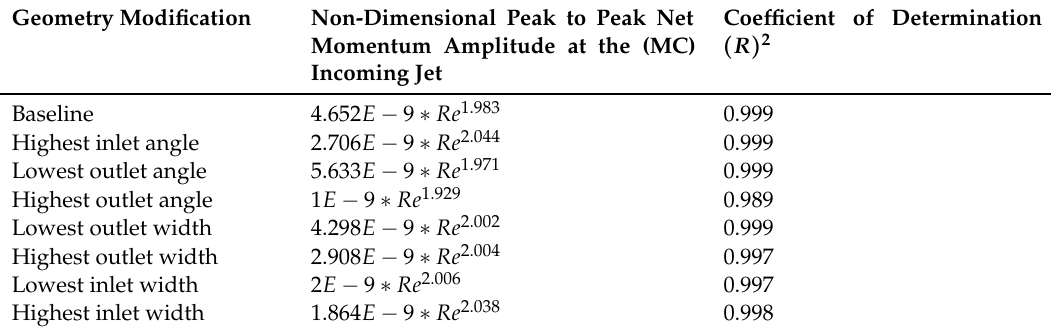
Table 6. Equations characterizing the evolution of non-dimensional peak to peak net momentum amplitude at the (MC) incoming jet, and as a function of the Reynolds number. These equations are valid in the range 8711 < Re < 32068.